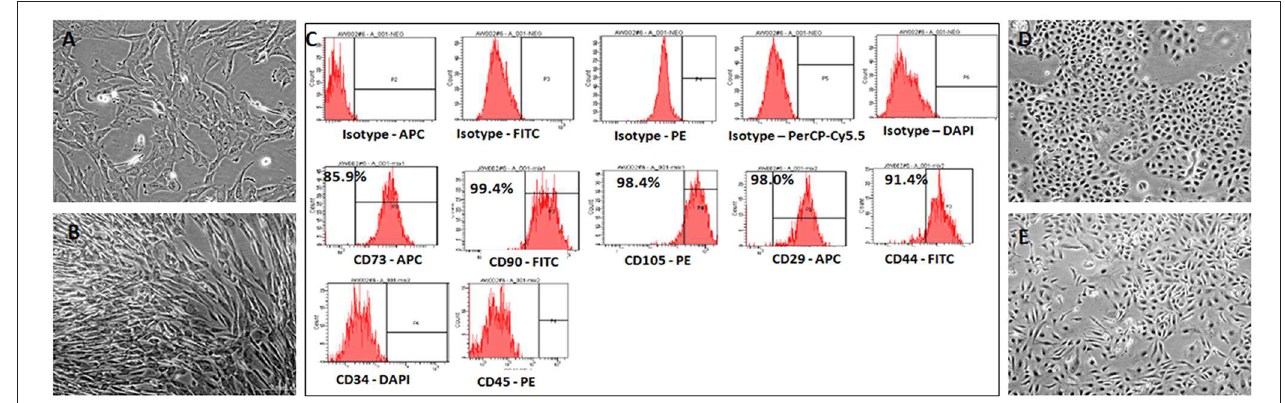
FIGURE 1 | Representative phase contrast images of the human umbilical cord Wharton’s Jelly Stem Cells (hWJSCs) in early and late cultures (A,B). The monolayer of hWJSCs shows the characteristic appearance as short fibroblasts in early passages, which become long fibroblasts in later passages. (C) Representative histogram of the MSC related CD surface markers on hWJSCs using Flrorescent activated cell sorting (FACS). Top panel (A) shows the respective isotype controls. The middle panel (B) shows the positive MSC related surface CD markers namely CD73, CD90, CD105, CD29, and CD44. The bottom panel (C) shows the MSC negative surface CD markers namely CD34 and CD45. (D,E) Representative phase contrast images of the human ovarian cancer cell lines OVCAR3 (D) and SKOV3 (E) in culture showing the characteristic epitheloid cells.